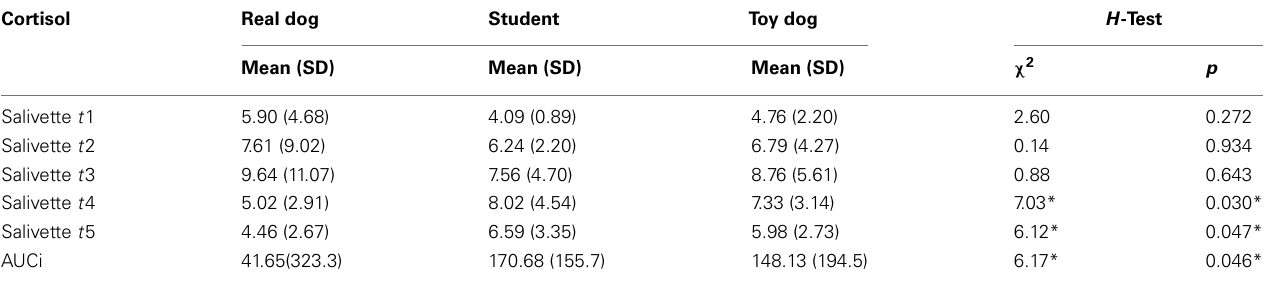
Table 2 | Mean cortisol levels (nmol/L; Salivettes at t 1– t 5) andAUCi ( N = 47), Kruskal–Wallis H -Test (df = 2) for support